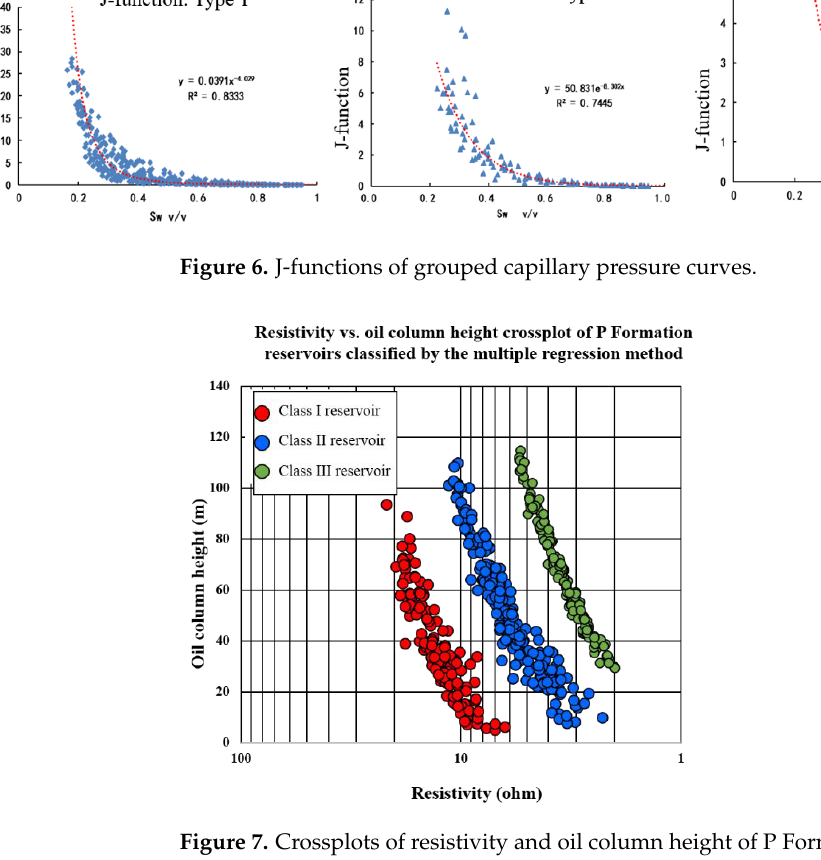
Figure 7. Crossplots of resistivity and oil column height of P Formation reservoirs.